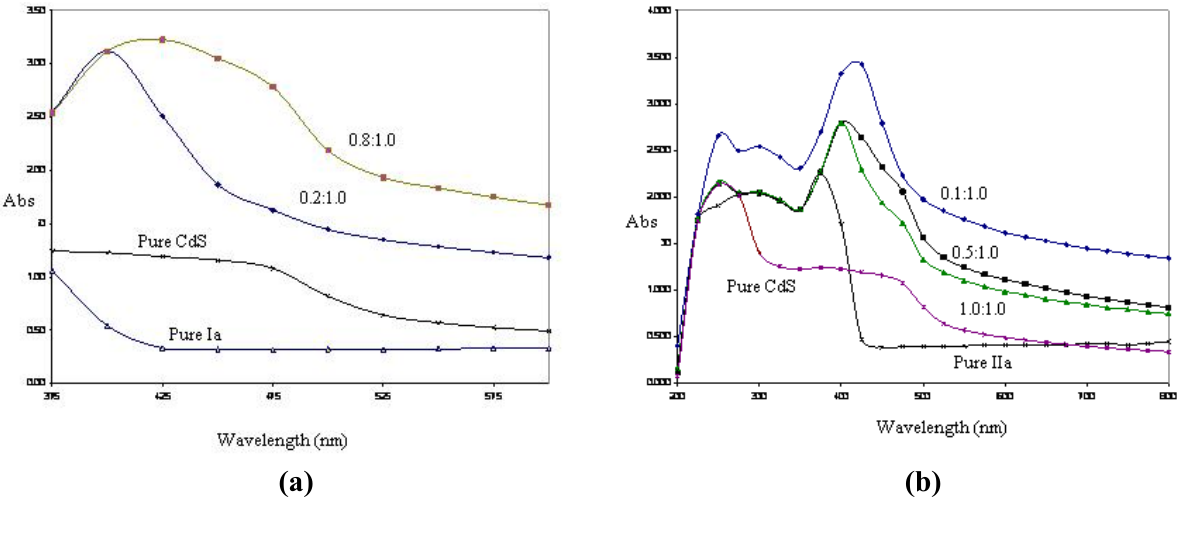
Figure 6. (a) UV/Vis spectroscopy analyses for pure CdS, pure Ia and CdS: Ia nanocomposites at 0.2:1.0 and 0.8:1.0 (w/w); (b) UV/Vis spectroscopic analyses for pure CdS, pure IIa and CdS: IIa nanocomposites at 0.1: 1.0, 0.5:1.0 and 1.0:1.0 (w/w).